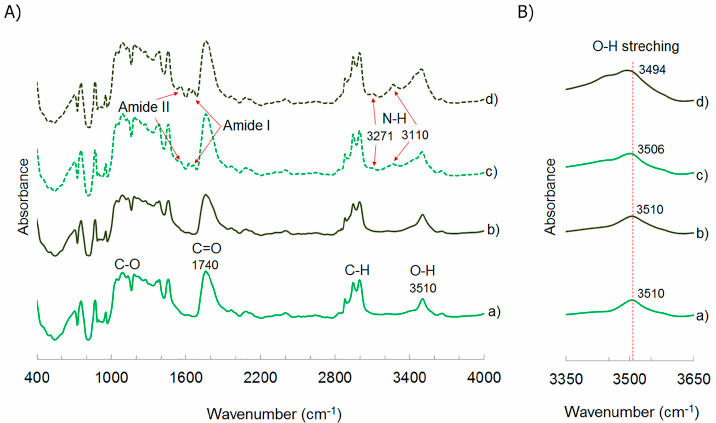
Figure 7. ( A ) FTIR spectra of: ( a ) extruded PLA with water and ethanol; ( b ) PLA-TEC7.5; ( c ) PLA- ChNC and ( d ) PLA-TEC7.5-ChNC showing the PLA and chitin characteristic peaks and ( B ) zoomed view of the FTIR peak of O-H stretching showing the shift of the O-H peak to a lower wavenumber when ChNC or ChNC together with TEC were added to PLA.